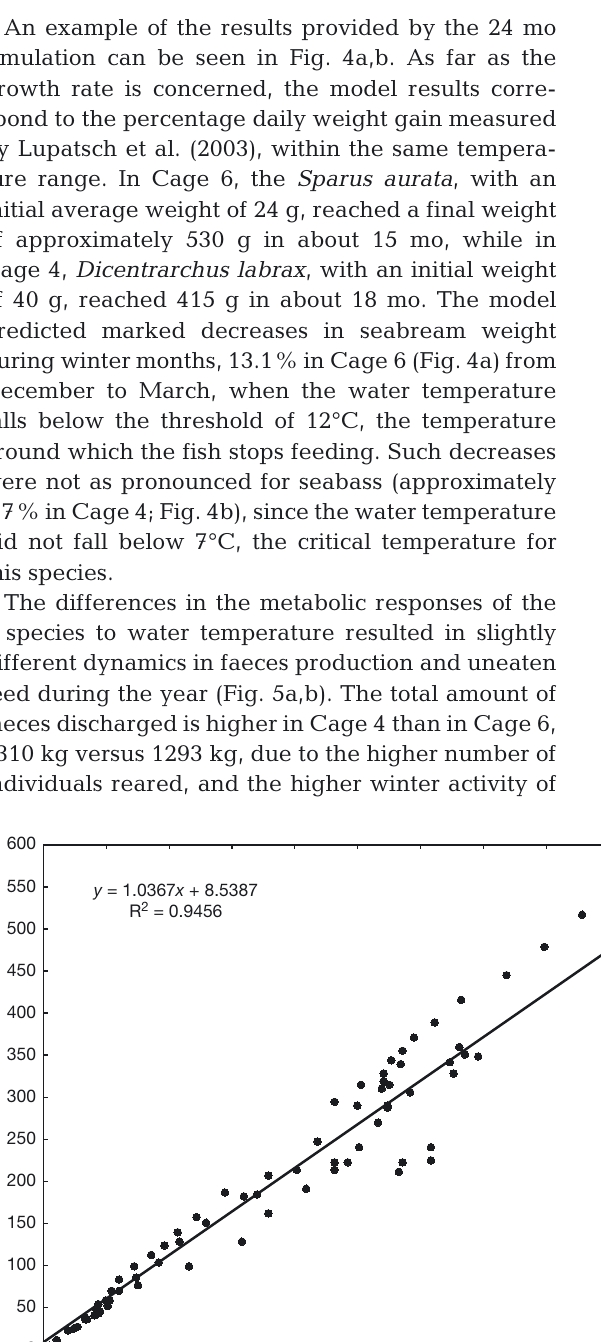
Fig. 3. Dicentrarchus labrax growth model validation: observed versus predicted